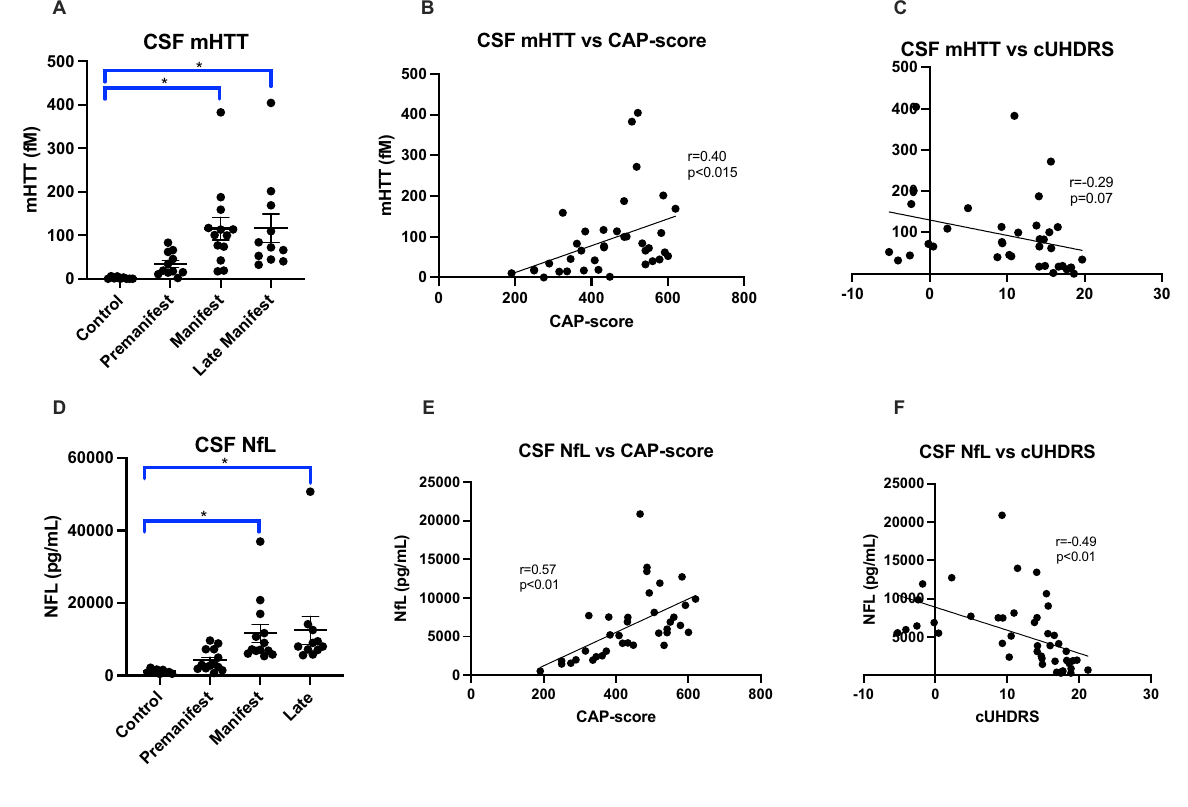
Figure 5. Cerebrospinal fluid mutant Huntingtin (mHTT) and Neurofilament light (NfL) in HD participants. CSF mHTT significantly increase with HD stage ( A ) and positively correlates with CAP-score ( B ) and negatively correlates with the composite Unified Huntington Disease Rating Scale (cUHDRS) ( C ). CSF NfL significantly increases with HD stage ( D ), and positively correlates with CAP-score ( E ) and negatively correlates with cUHDRS ( F ). An asterisk (*) indicates a p < 0.05 for post-hoc comparisons. Data are shown as individual data points with the mean ± sem .